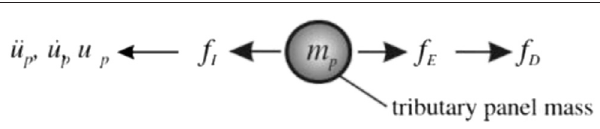
FIGURE 14 | A mathematical model used to calculate the maximum forces in a restrainer system: € u p , _ u p , and u p are the acceleration, velocity and displacement of the panel at the level of the restrainer, and f D , f E and f I are the damping, internal and inertial forces.